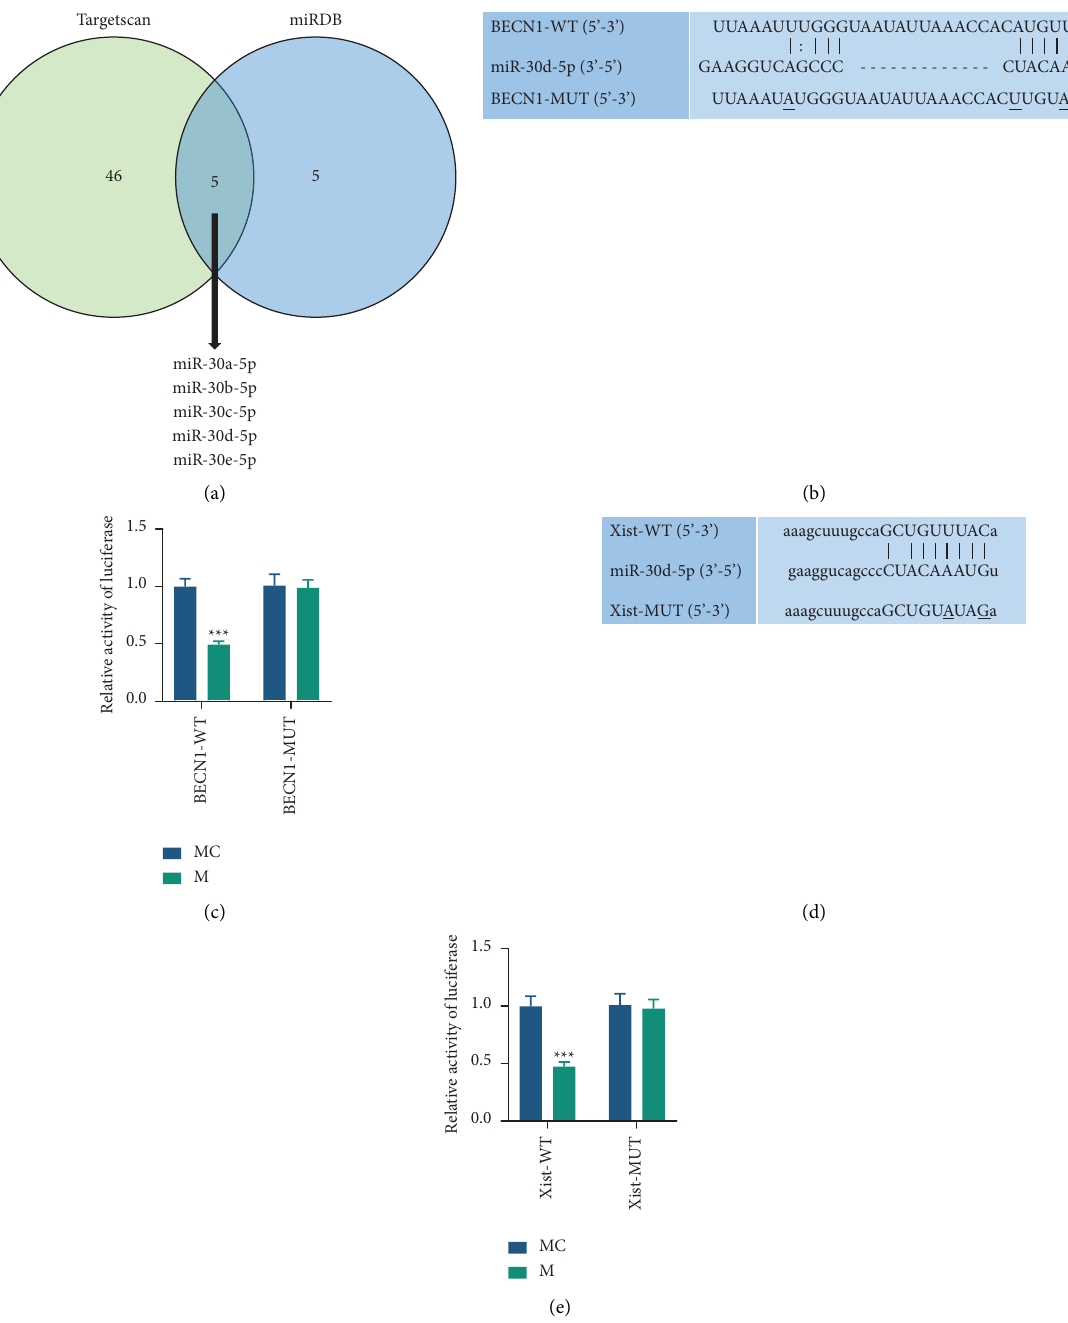
Figure 2: Validation of the targeting relationship of XIST/BECN1 and miR-30d-5p. (a) Te miRDB (https://mirdb.org/index.html) and TargetScan (https://www.targetscan.org/vert_72/) were used to search the miRNAs targeting BECN1. Te results were intersected by a Venn diagram. (b) Te binding sites between miR-30d-5p and BECN1 were predicted by TargetScan. (c) Te relationship between miR-30d-5p and BECN1 was verifed by dual-luciferase reporter assay. (d) Te binding sites between miR-30d-5p and XIST were predicted by Starbase (https://starbase.sysu.edu.cn/). (e) Te relationship between miR-30d-5p and XISTwas verifed by dual-luciferase reporter assay. Quantifed values were presented as mean ± standard deviation of at least three independent experiments. ∗∗ p < 0 . 001 vs. MC. qRT-PCR: quantitative real-time polymerase chain reaction. GAPDH: glyceraldehyde-3-phosphate dehydrogenase. PAS: periodic acid Schif reaction. DN: diabetic nephropathy. M: mimic. MC: mimic control; XIST: X inactive specifc